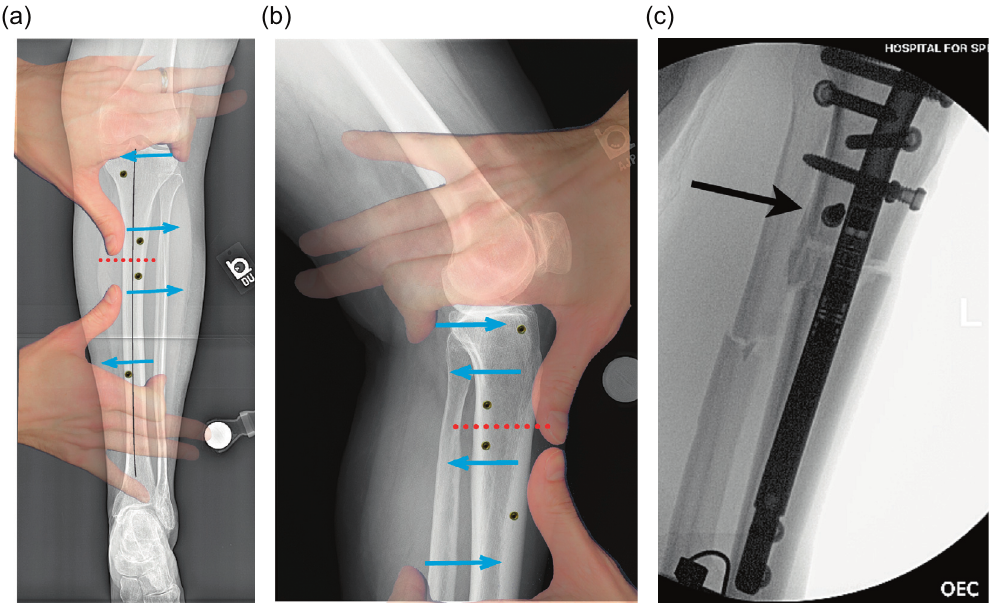
Figure 11. (a) This shows a different patient’s X-rays. The valgus correction is maintained by placing blocking screws in the concavity of the deformity (lateral aspect). Peripheral blocking screws can be used as well. (b) The sagittal plane requires at least one blocking screw in the proximal fragment near the osteotomy (the screw shown at the entry site of the ILN is theoretical and is never used). (c) This lateral film shows a well-placed posterior blocking screw (arrow).